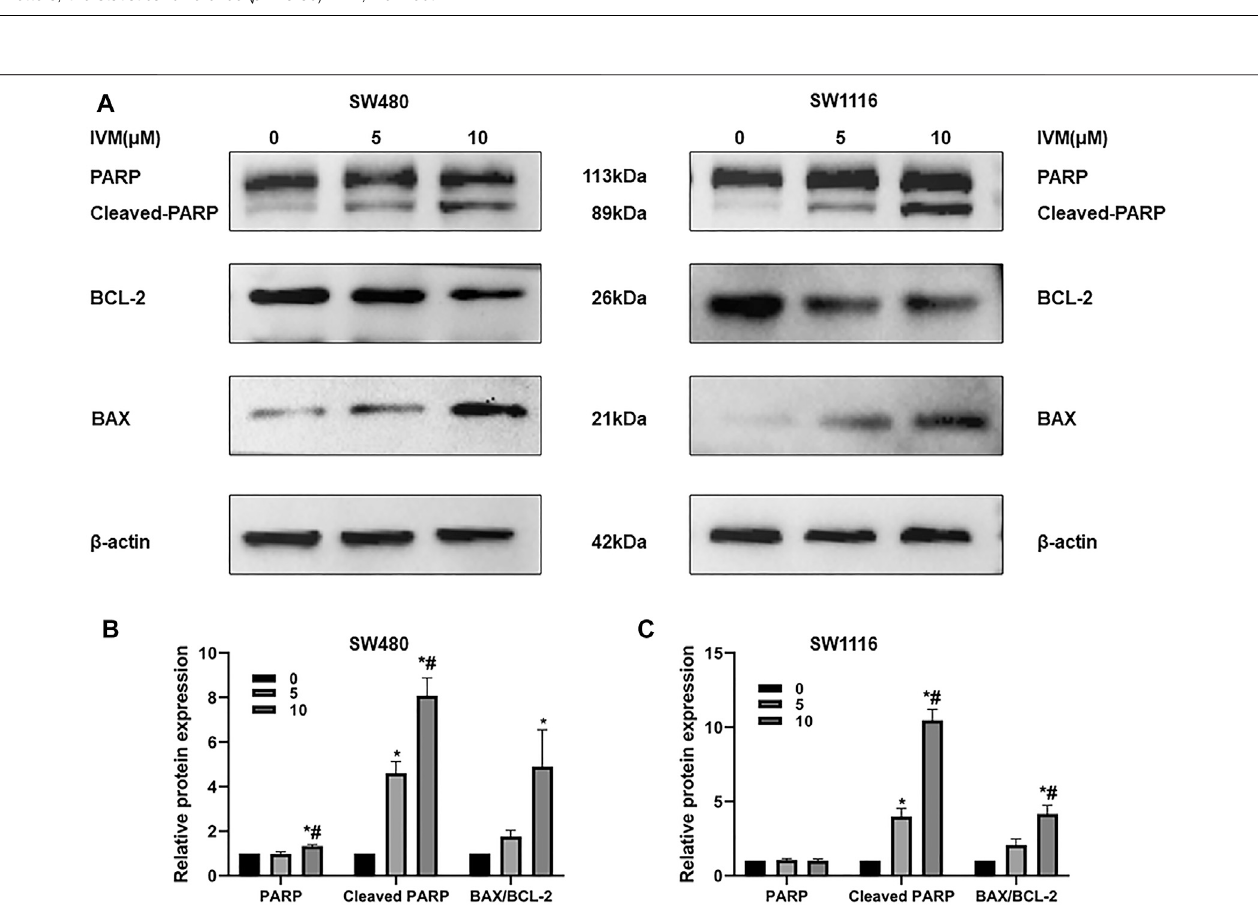
FIGURE6| In fl uenceofivermectinontheBax,Bcl-2,PARP,andCleaved-PARPexpressioninSW480andSW1116cells.SW480andSW1116cellsweretreated withindicatedconcentrationsofivermectin(0,5,and 10 μ M) for6 handthen werecollectedtodetermine theexpression ofapoptosis-relatedgenes(Bax, Bcl-2, PARP, and Cleaved-PARP) by Western blot assay described as the “ Materials and Methods ” section. Representative gels for SW480 (A, Left panel) and SW1116 (B, Right panel) cells were shown, and data were summarized from three independent experiments (B and C) . The relative value was presented as fold induction to that of the control, which was normalized to β -actin. * p < 0.05, compared with the control group (0 µM); # p < 0.05, compared with the 5 µM group. IVM, ivermectin.